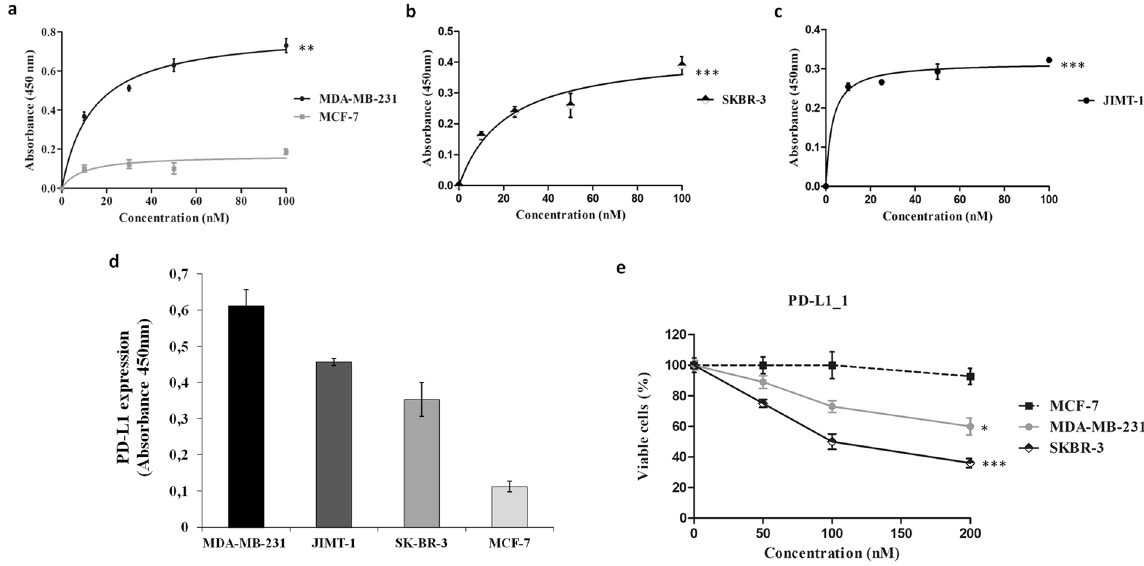
Figure 1. Binding curves and anti-tumor effects of PD-L1_1 mAb on breast cancer cells. The binding curves were obtained by ELISA assays of PD-L1_1 tested at increasing concentrations on MDA-MB-231 ( a ), SK-BR-3 ( b ) and JIMT-1 ( c ) cells. MCF-7 cells were used in parallel assays as a negative control (grey curve, panel a). The expression of PD-L1 on the indicated tumor cell lines was tested by cell ELISA with a commercial anti-PD-L1 antibody ( d ). Effects of PD-L1_1 on MDAMB231 (gray curve), SK-BR-3 (black curve) or MCF-7 cells(dashed line). Cells were treated for 72 h with PD-L1_1 mAb tested at increasing concentrations and cell survival was expressed as percentage of viable cells with respect to untreated cells ( e ). Error bars depicted means ± SD. P values for the indicated treatment relative to untreated cells, are: *** P ≤ 0.001; ** P < 0.01; * P <